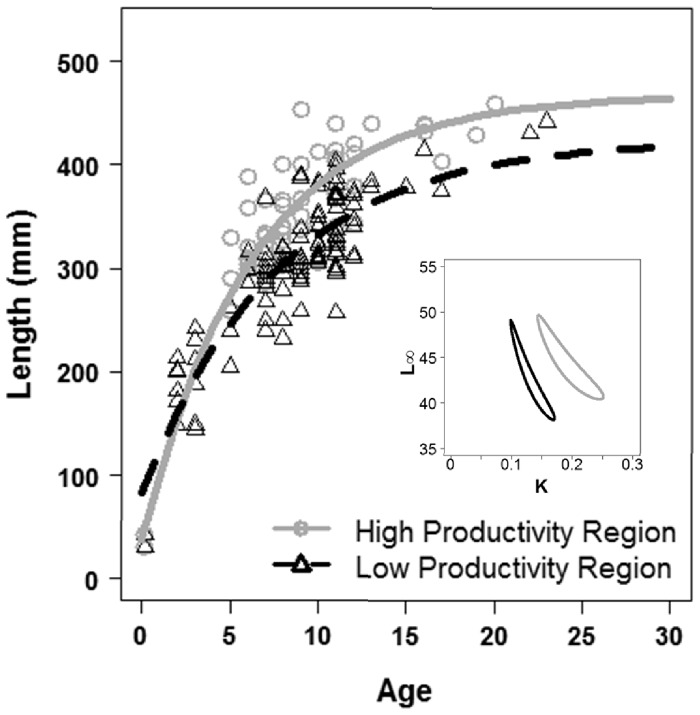
von Bertalanffy growth curves for grass rockfish (Sebastes rastrelliger) in the Santa Barbara Channel, CA, USA.Solid line represents the fit to data from the high productivity subregion (circles) and the dashed line represents the fit to data from the low productivity subregion (triangles) Inset depicts 95% confidence intervals around estimates of K and L
∞ (Kimura 1980).